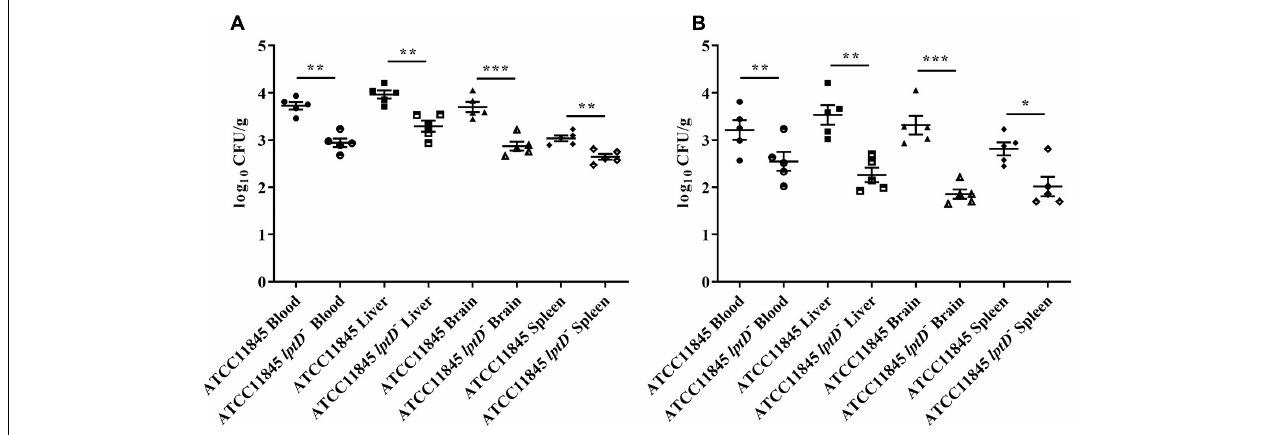
FIGURE 6 | Colonization of R. anatipestifer ATCC11845 and ATCC11845 lptD − in vivo . The strain ATCC11845 (10 9 CFU) and ATCC11845 lptD − (10 9 CFU) strains were injected into the leg muscles of 3-day-old ducklings. At 12 h (A) and 18 h (B) postinfection, bacteria were isolated from the livers, brains, spleens, and blood according to the methods described in the “Materials and Methods” section. The data points represent the log 10 CFU/g of individual animals in the indicated organs, with the bars representing the median values ( n = 5), ∗ , p < 0.05, ∗∗ , p < 0.01, and ∗∗∗ , p < 0.001.